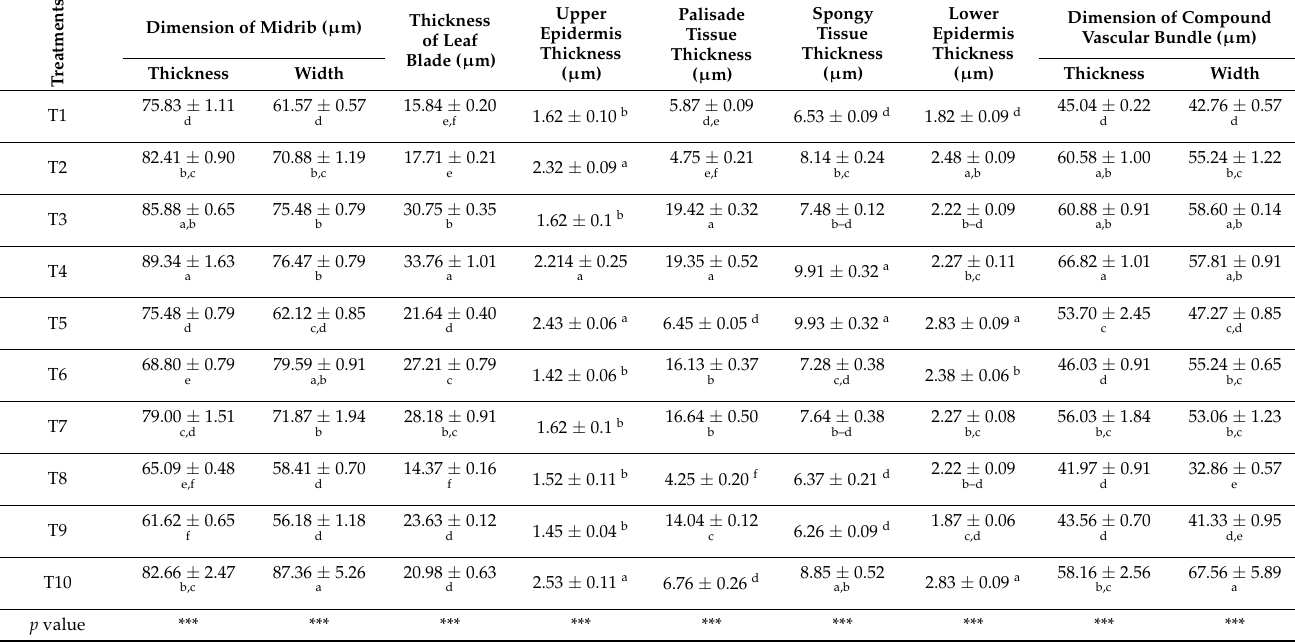
Table 4. Anatomical modification of grapevine leaves as affected by salinity (NaCl) and brassinolide (BL) during the 2 nd